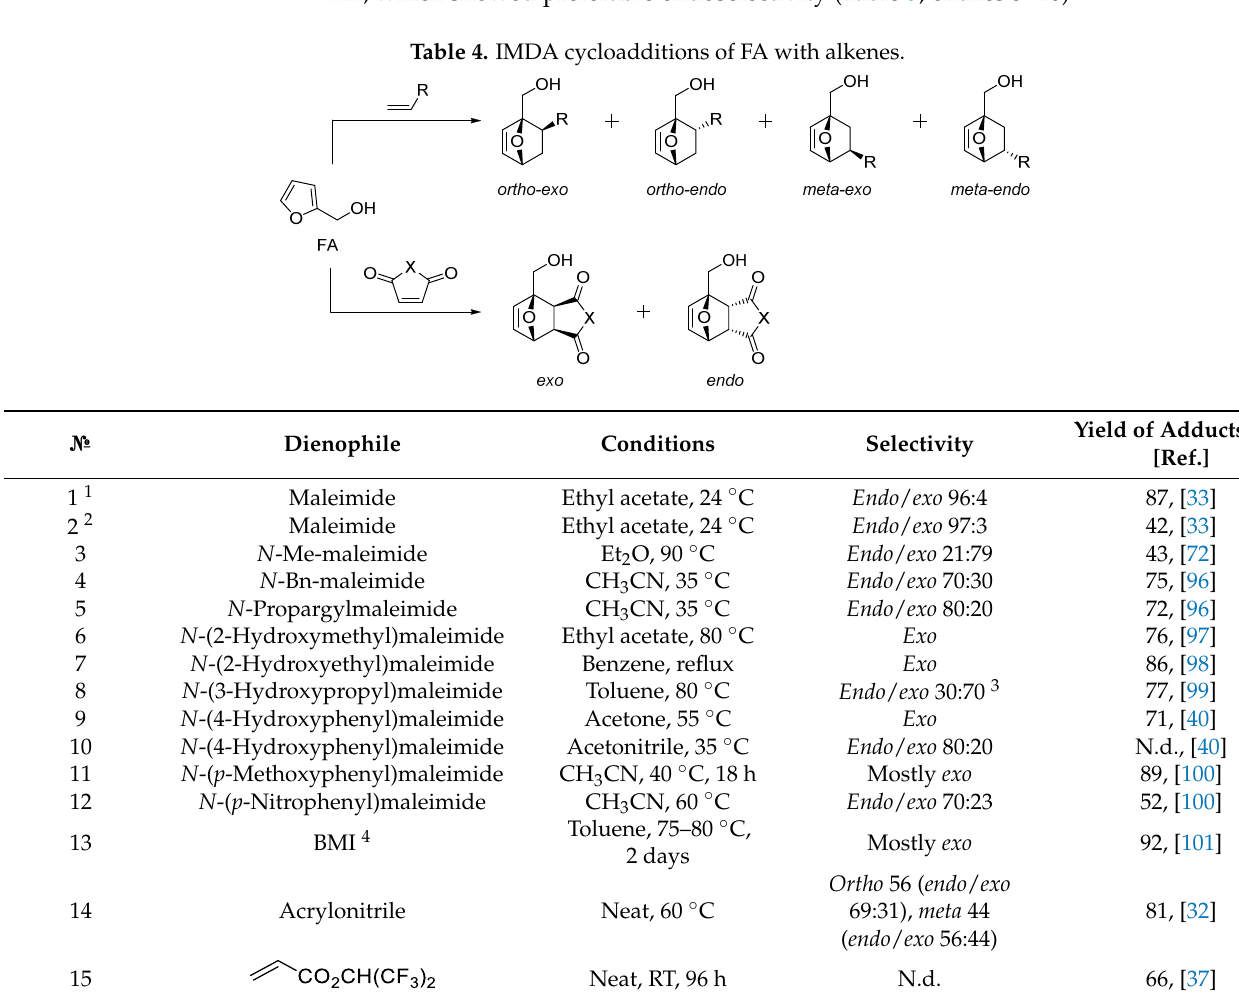
Table 4. IMDA cycloadditions of FA with